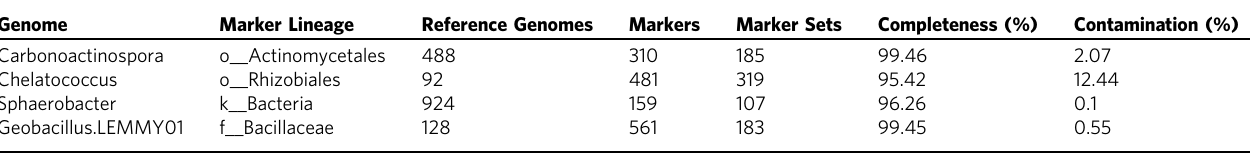
Genome statistics were determined according to the presence or absence of marker genes and the expected colocalization of these genes compared with the marker lineage 64